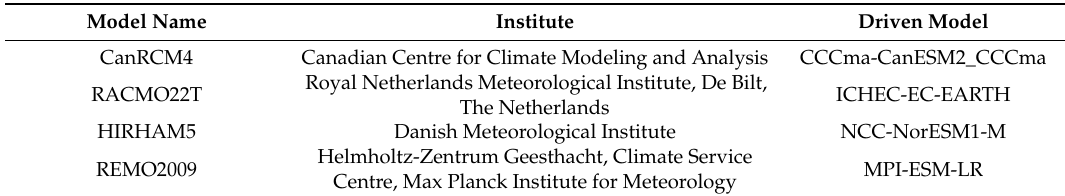
Table 3. Details of the regional climate models